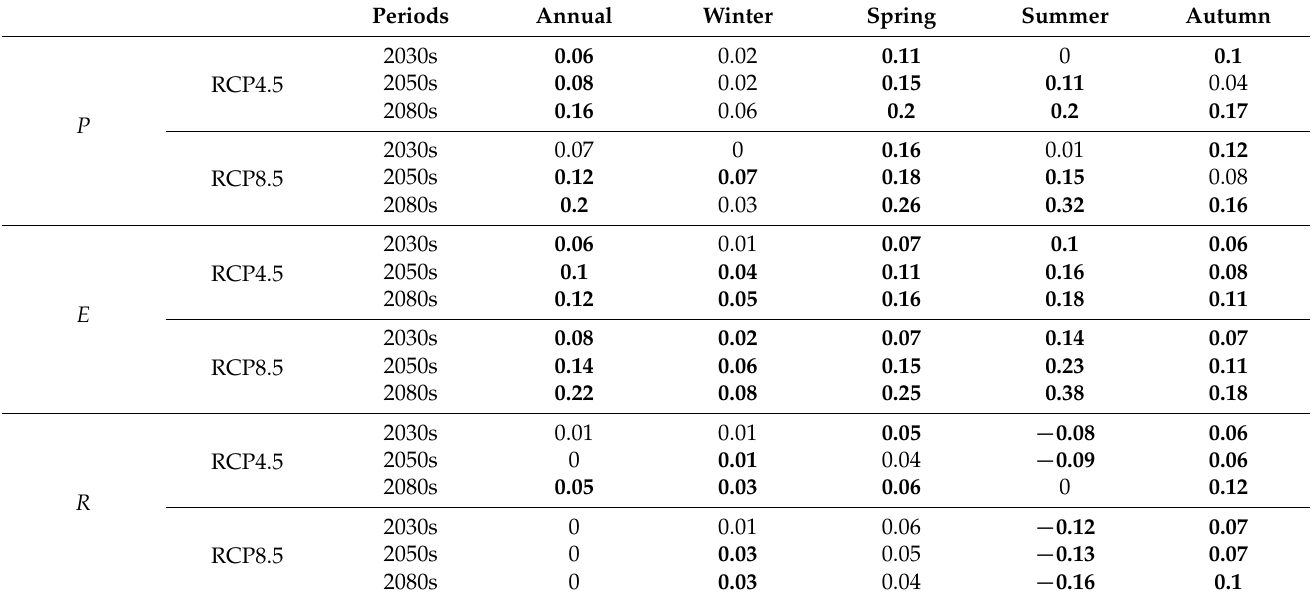
Table 3. Projected changes (mm/day) in precipitation, evapotranspiration, and runoff at different future periods ( P , E , and R denote precipitation, evapotranspiration, and runoff, respectively).